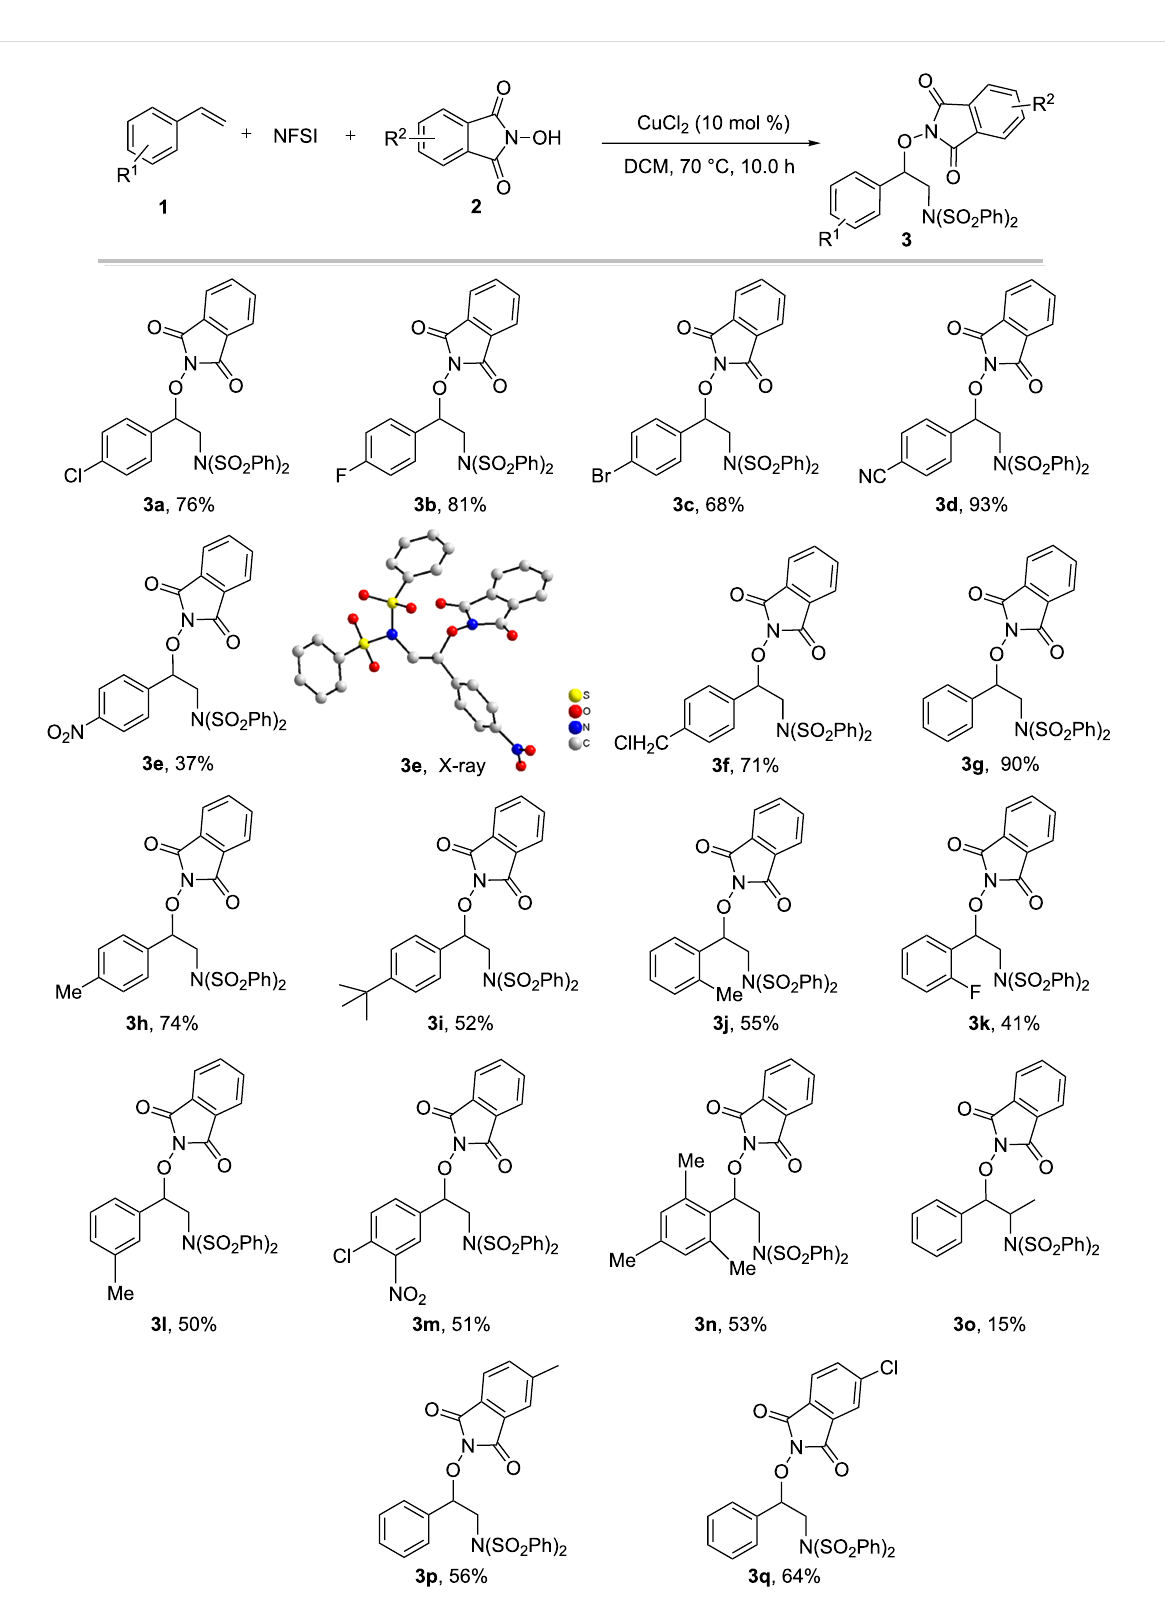
Figure 2: The copper-catalyzed three-component aminooxygenation of styrenes with NFSI and NHPI derivatives. Reaction conditions: 1 (0.9 mmol, 3.0 equiv), NFSI (1.2 mmol, 4.0 equiv), 2 (0.3 mmol, 1.0 equiv), CuCl 2 (10 mol %), DCM (2.0 mL), N 2 , 70 °C, 10.0 h. Isolated